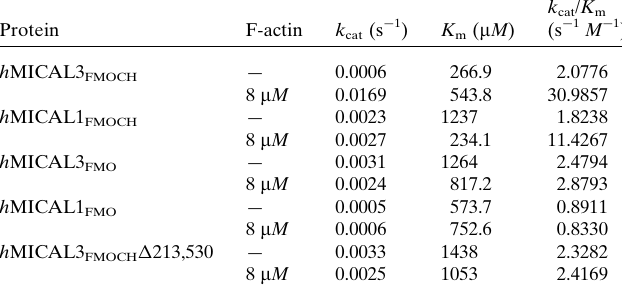
Table 2 Steady-state kinetic parameters of various MICALs.